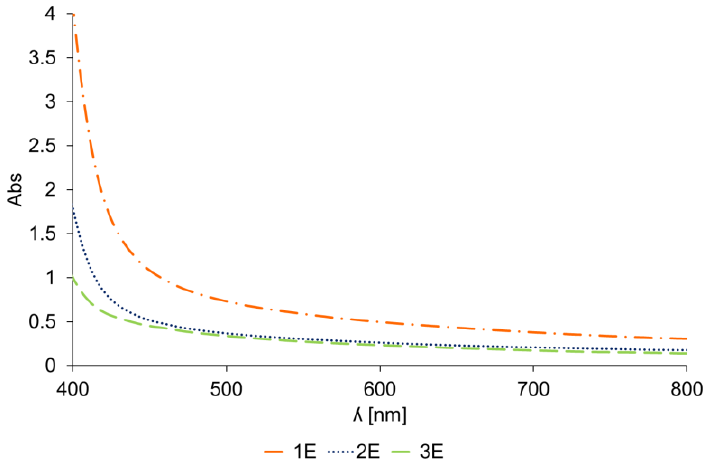
Figure 4. The VIS absorption spectra of 1st extraction (1E), 2nd extraction (2E) and 3rd extraction (3E).